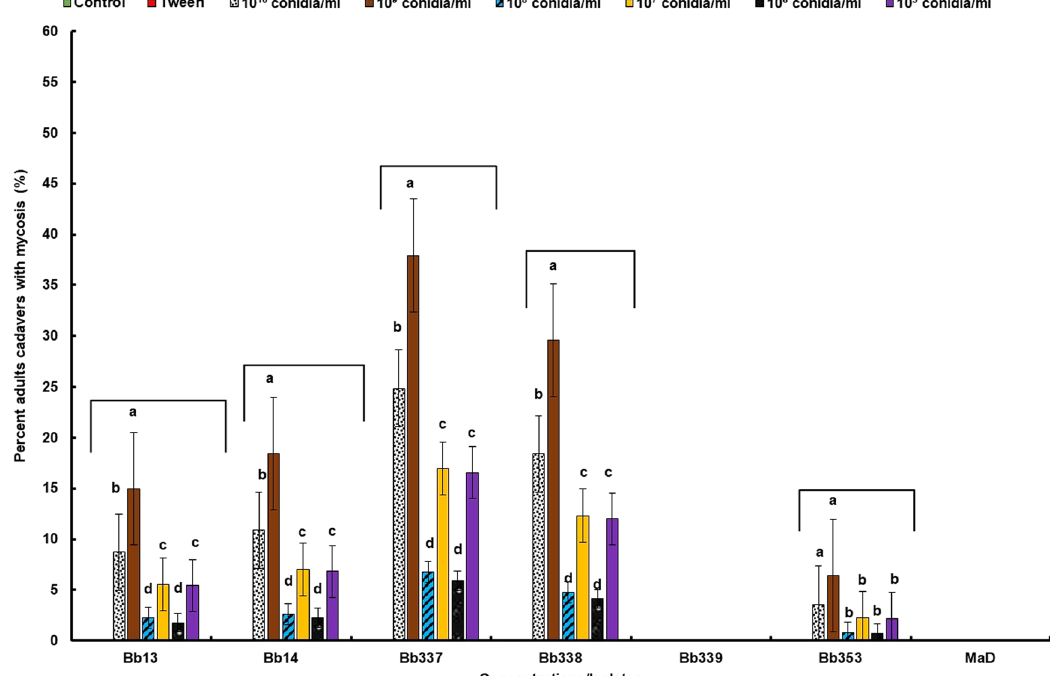
Fig. 8 Cadavers Zeugodacus cucurbitae adults with fungal growth after treatment with different concentrations of isolates of Beauveria bassiana and Metarhizium anisopliae in pupal inoculation